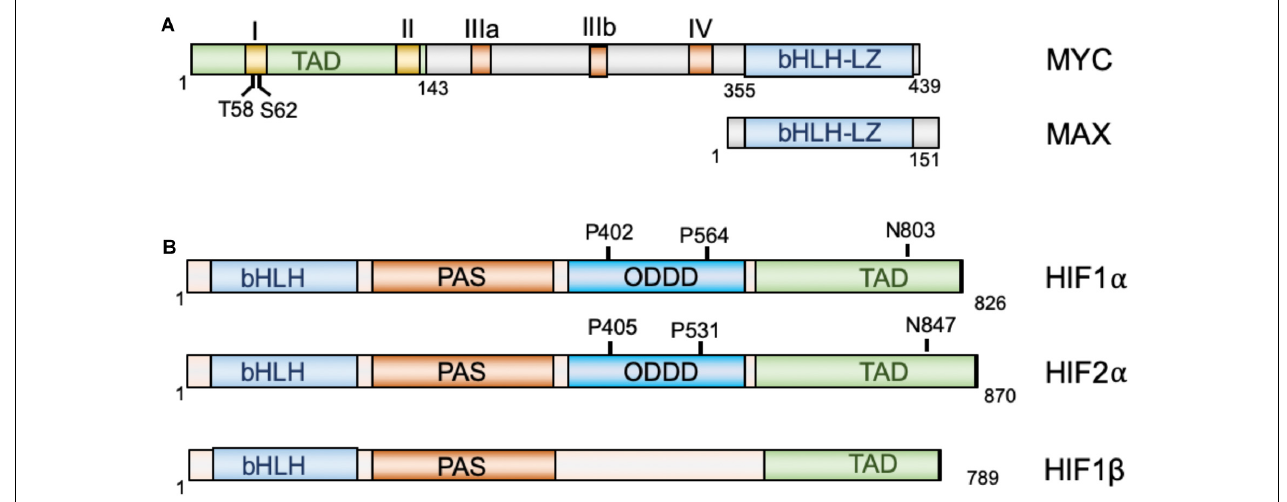
FIGURE 1 | Diagrams of MYC and MAX (A) and HIF proteins (B) . MYC and Max dimerize via their bHLH-LZ domains, whereas HIF1 α and HIF2 α dimerize with HIF1 β via their N-terminal bHLH domains. TAD, transactivation domain; bHLH, basic helix-loop-helix; LZ, leucine zipper; PAS, Per-Arnt-Sim homology; ODDD, oxygen-dependent degradation